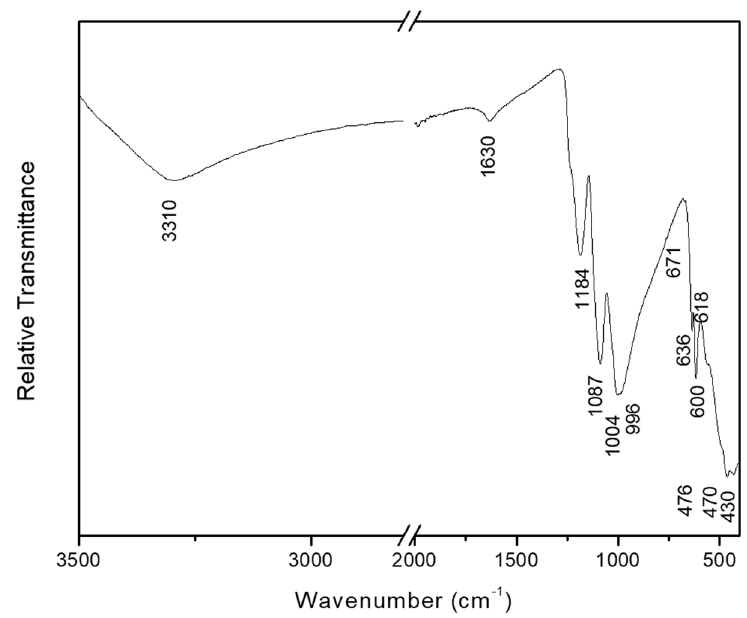
Figure 2. FTIR analysis of the synthetic mercury jarosite.